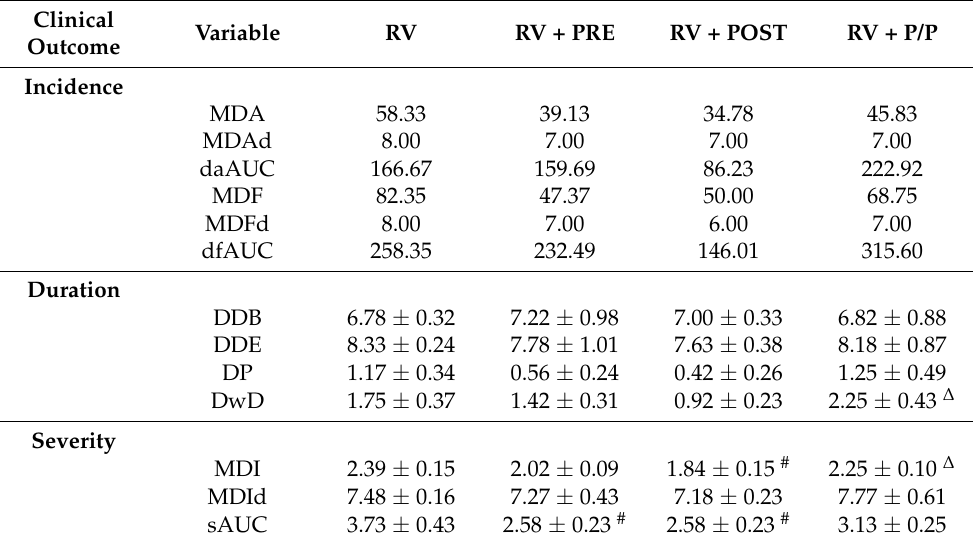
Table 2. Clinical variables determining the diarrhea process in the RV groups. Clinical Variable RV RV + PRE RV + POST Outcome Incidence MDA